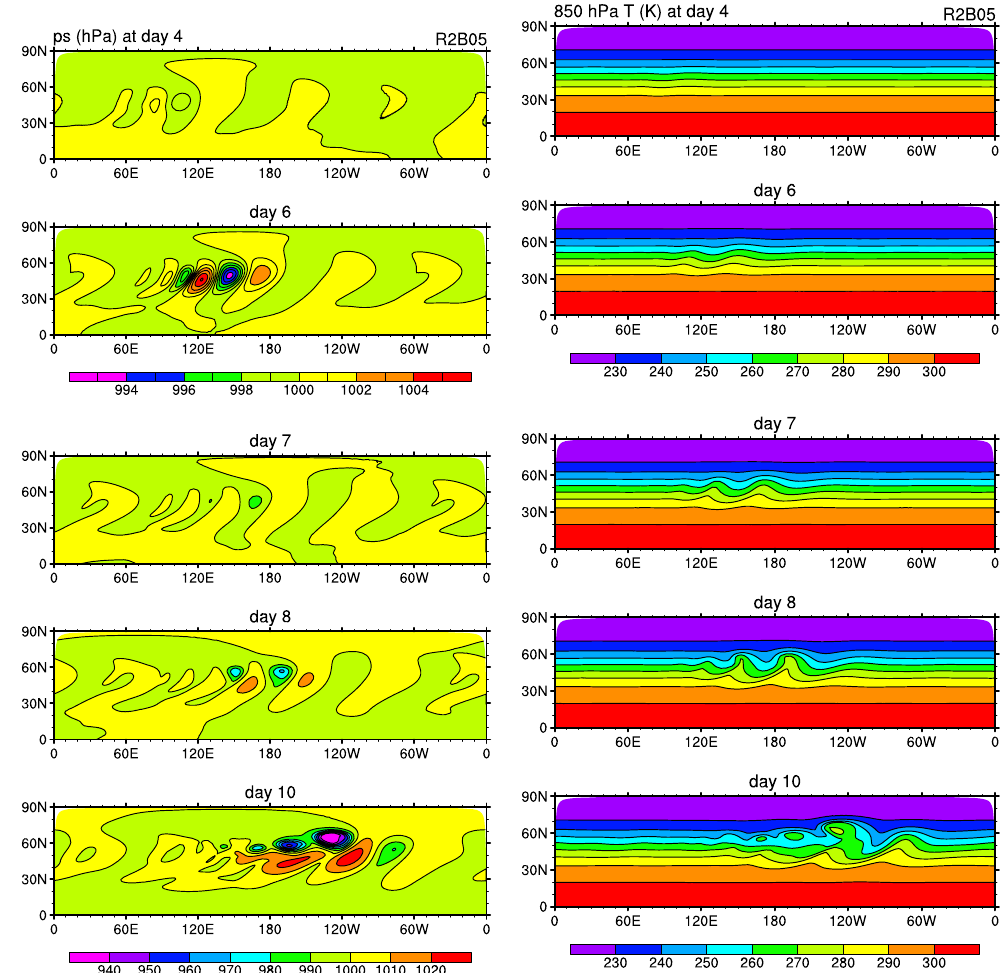
Fig. 6. Evolution of the baroclinic wave in the Jablonowski and Williamson (2006a,b) test case, as shown by the surface pressure (unit: hPa, left column) and 850hPa temperature (unit: K, right column) simulated by the new dynamical core at R2B5 (70km) resolution. Note that in the left column, the two upper panels use a different color scale than the lower panels. Further details can be found in Sect.